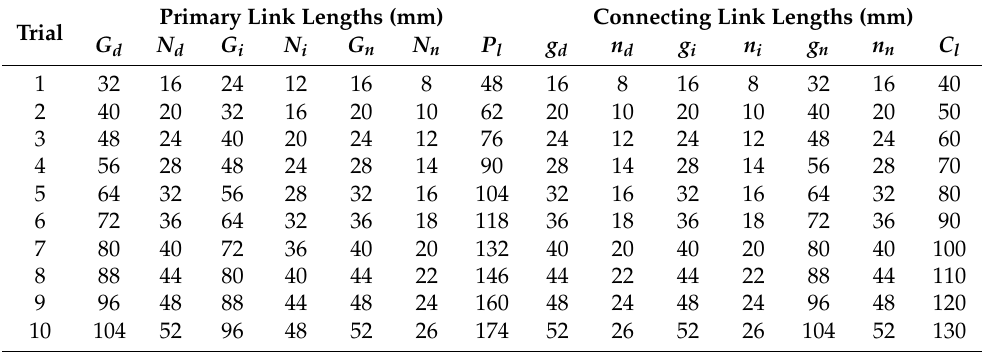
Table 6. Rotary planting mechanism combinations for primary and connecting link length trials.